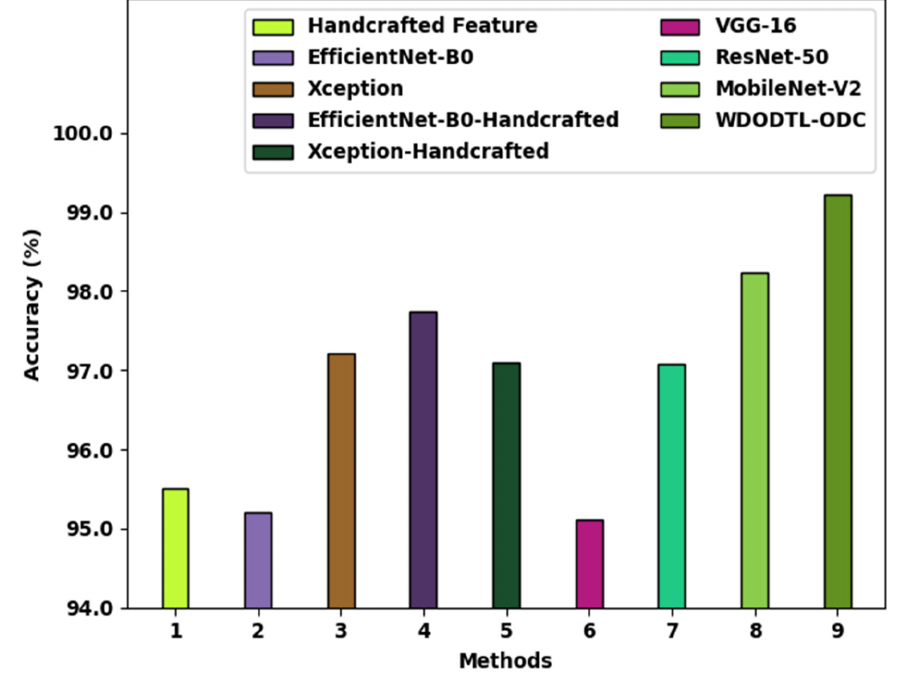
Figure 9. Accu y analysis of WDODTL-ODC technique with existing algorithms. Figure 9. 𝐴𝑐𝑐𝑢 (cid:3052) analysis of WDODTL-ODC technique with existing algorithms. Figure 10 defines a brief 𝑝𝑟𝑒𝑐 (cid:3041) inspection of the WDODTL-ODC approach with ex- isting techniques. The figure implied that the handcrafted feature, EfficientNet-B0, and VGG-16 models have resulted in minimal classification 𝑝𝑟𝑒𝑐 (cid:3041) of 98.34%, 95.47%, and 97.61% respectively. At the same time, the Xception, EfficientNet-B0-Handcrafted, Xcep- tion-Handcrafted, and ResNet-50 models have reached somewhat improved 𝑝𝑟𝑒𝑐 (cid:3041) val- ues of 94.84%, 98.04%, 94.85%, and 98.32% correspondingly. But, the MobileNet-v2 system has shown reasonable performance with 𝑝𝑟𝑒𝑐 (cid:3041) of 97.39%, the WDODTL-ODC algorithm has been able higher 𝑝𝑟𝑒𝑐 (cid:3041) of 98.86%.